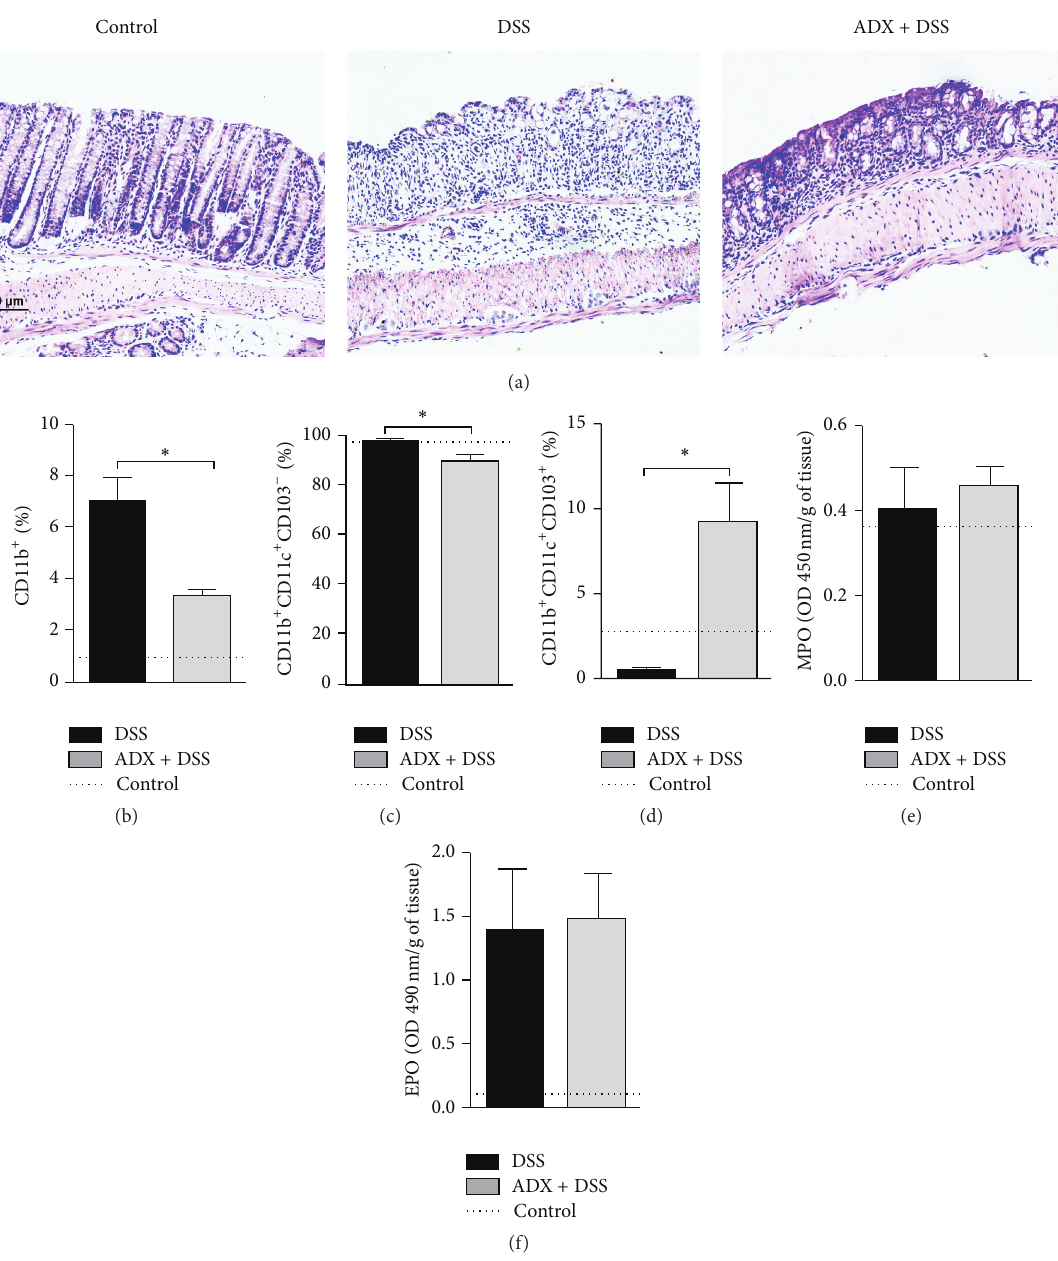
Figure 3: Adrenal-derived mediators modulate local tissue damage. C57BL/6 mice were adrenalectomized and exposed to dextran sulfate sodium (DSS) 3%. The colon was collected on the 6th day of colitis for histological analysis (a) in (b) immunophenotyping of CD11b + cells, (c) dendritic proinflammatory cells (CD11b + CD11c + CD103 − ), and (d) tolerogenic dendritic cells (CD11b + CD11c + CD103 + ), evaluated by flow cytometry. (e) Myeloperoxidase (MPO) and (f) eosinophil peroxidase (EPO) assays. DSS: C57BL/6 mice exposed to DSS; ADX + DSS: C57BL/6 adrenalectomized mice exposed to DSS. The dotted lines correspond to the control group of C57BL/6 mice without colitis. Results are representative of two independent experiments, with 5 mice/group. ∗ 𝑝 < 0.05